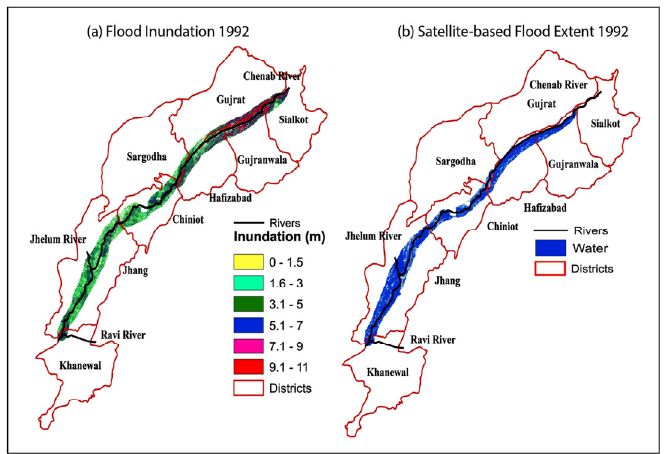
Figure 6. ( a , b ) Simulated and observed inundation extents for the 1992 flood. The validation of the model was performed by selecting four higher values of the Table 4. Validation assessment of the model using overall accuracy, F1, and F2 for the 2014 flood. main channel n against the floodplain n values, as used in the calibration, as presented in Table 4. Landsat 7 ETM+, Landsat 8 OLI, and MOD09A1 and MOD09GA were used for the NDWI, MNDWI 1, and MNDWI 2, with upper threshold values recorded from the literature. The final observed area was recorded as 3489 km 2 after blending outputs obtained using different approaches for each satellite product. The overall accuracy ranged from 76.6% to 94.2%. The n values of 0.06 for the floodplain and 0.06 for the main channel were the best combination with higher values of F1 and F2. The comparison between simulated and observed inundation extents for 2014 is presented in Figure 7a,b, indicating good agreement between inundation extents. There was good agreement in almost all the districts, but the model simulated more inundated area in the lower part of the Hafizabad district and upper parts of the Chiniot district lying near the river.